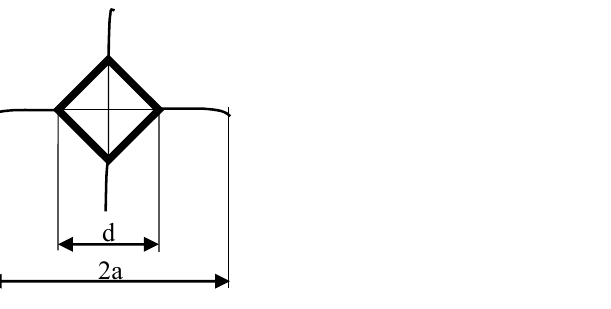
Figure 13. Schematic of micro-indentation using Vickers’s hardness machine test.